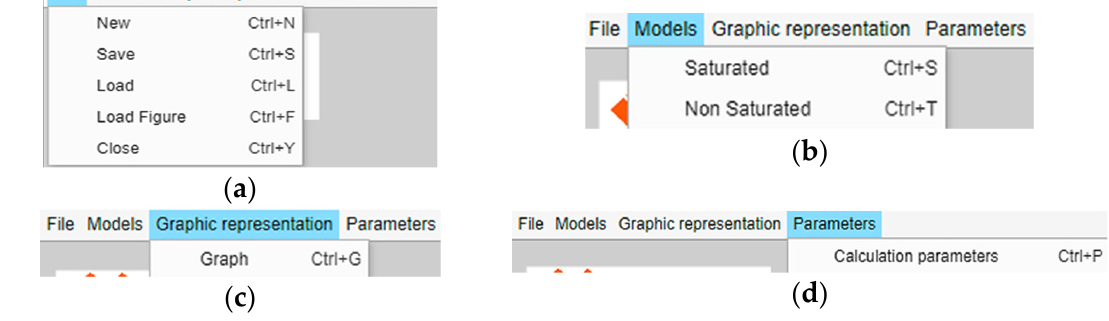
Figure 8. ( a ) File management submenu, ( b ) Access to model change, ( c ) Access to graphic repre- sentations, ( d ) Calculation parameter window.